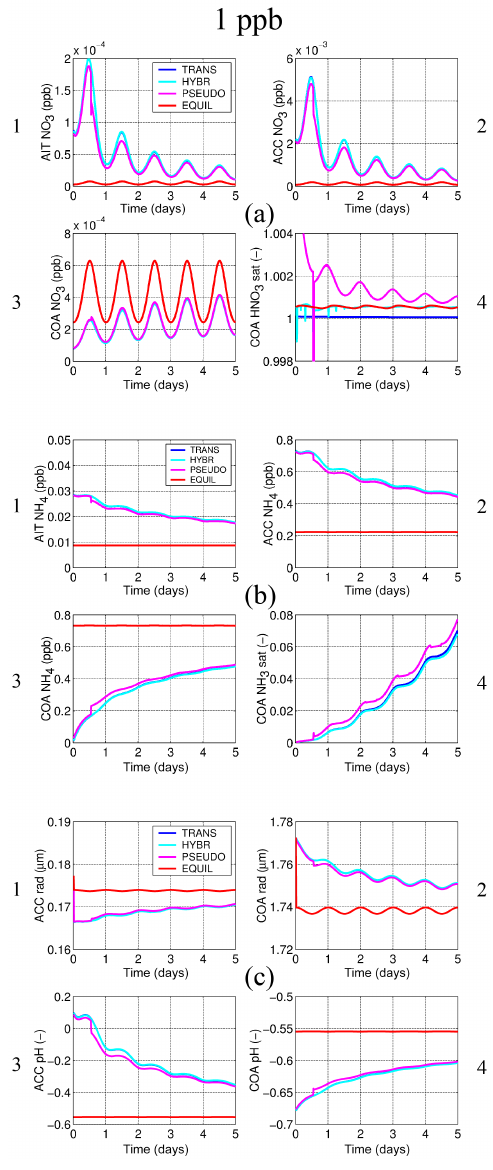
Figure 6. Size-resolved box-modelling evaluation of HyDiS-1.0 with H 2 SO 4 aerosol and initial mixing ratios of HNO 3 (g) and NH 3 (g) of 1ppb (series 1; see text). The solver is run in the fully dy- namic (TRANS), hybrid dynamic and equilibrium (HYBR), equi- librium with pseudo-dynamic correction (PSEUDO), and full equi- librium configurations. Atmospheric volume mixing ratios of ni- trate (a) and ammonium (b) in the aqueous phase as a function of time for the Aitken (1), accumulation (2), and coarse (3) mode. For the coarse mode, the degree of saturation (4) with respect to nitric acid and ammonia is also shown. Accumulation- and coarse-mode radii (c.1 – 2) and pH (c.3 – 4) , respectively. A diurnal temperature cy- cle of T = 298 . 15 ± 5K is imposed. Note that TRANS may not be distinguishable from HYBR, or even both of them from PSEUDO, due to similar